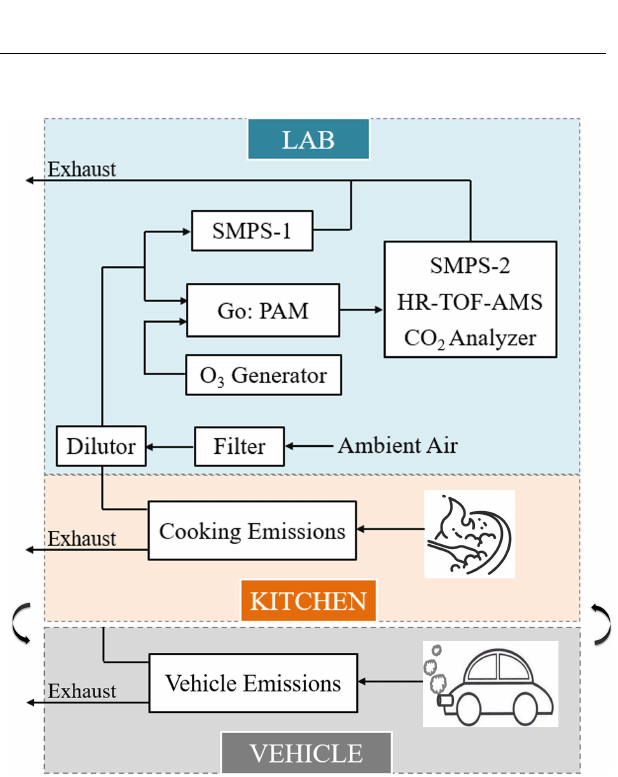
Figure 1. Schematic of experiment